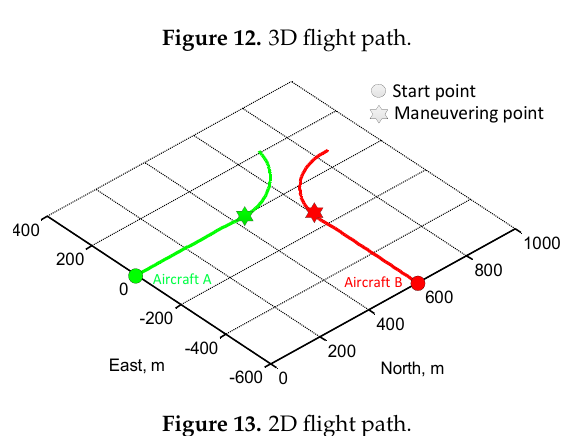
Figure 13. 2D flight path.